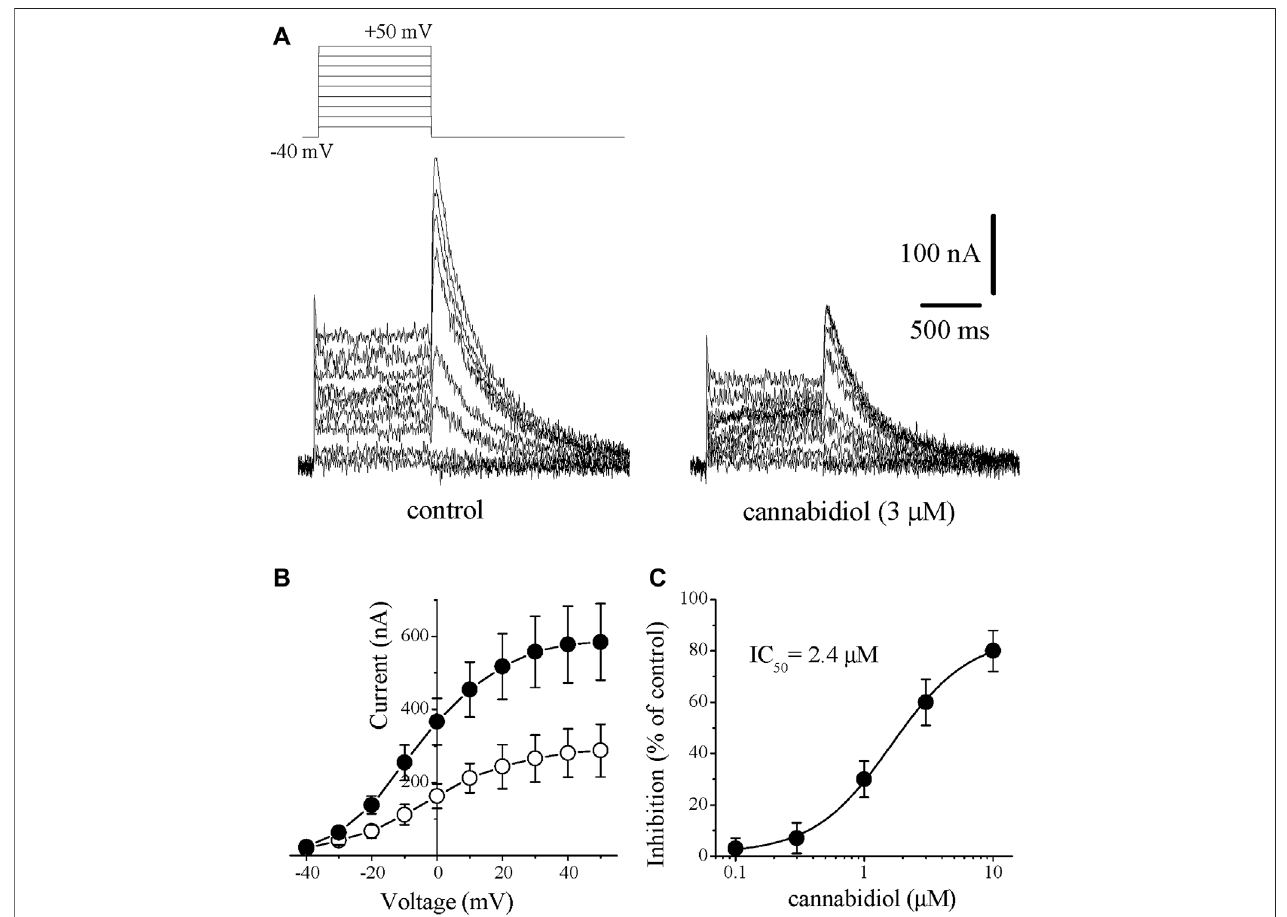
FIGURE 4 | Cannabidiol suppresses the I Kr tail current. Original traces of currents recorded in rabbit cardiomyocytes are presented in panel (A) . I Kr tails were measuredasatime-dependentcomponentofthetailcurrentactivatedinresponsetomembranerepolarization.Recordingsincontrolandafter10 mininthepresenceof 3 μ M CBD are presented on the left and right panels, respectively. The pulse protocol to evoke I Kr is presented in the inset (B) Current-voltage relation showing the cumulative effect of 3 μ M CBD. Data points represent the averages of currents recorded with the same protocol described above in 6 cells before (control, fi lled circles) and after (open circles) CBD application (C) Concentration-inhibition curve for CBD inhibition of I Kr tails (n (cid:1) 5 – 8).